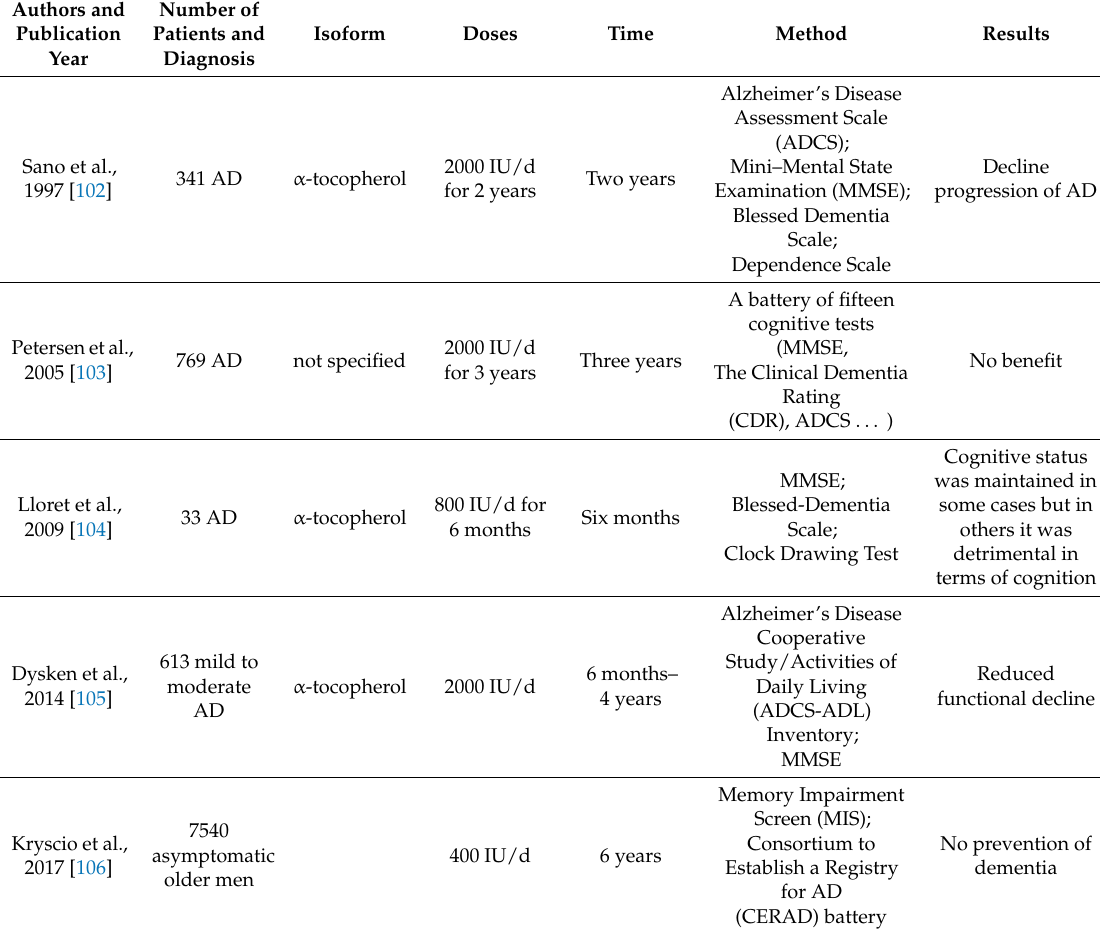
Table 3. Clinical trials about the effectiveness of vitamin E in the AD